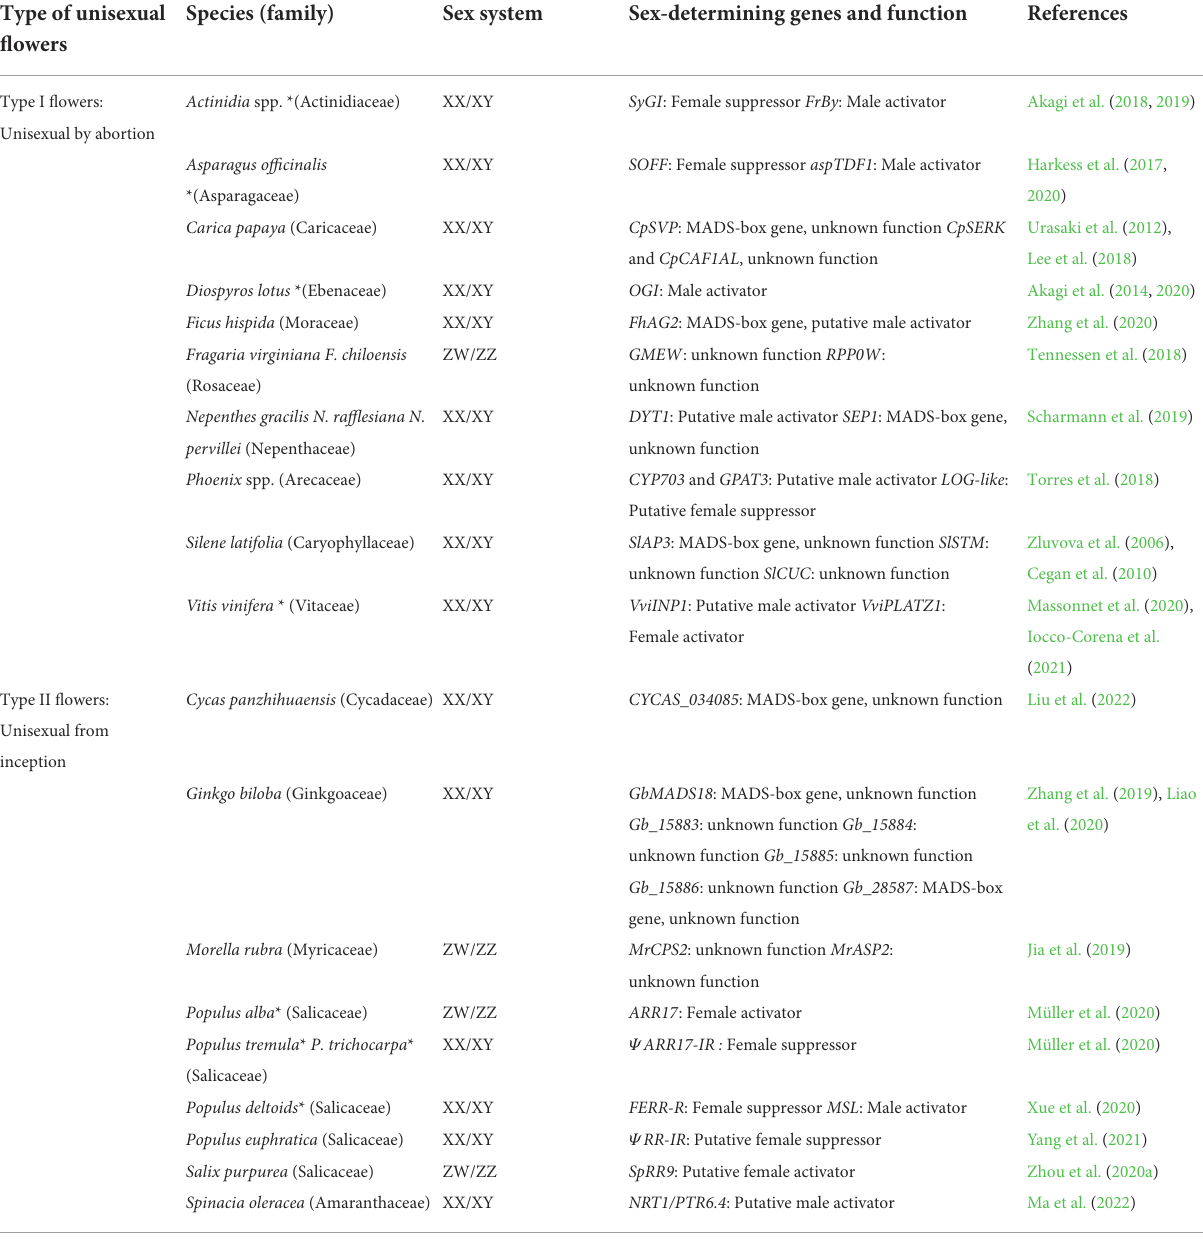
TABLE 1 Sex-determining genes and/or strong candidates identified in dioecious